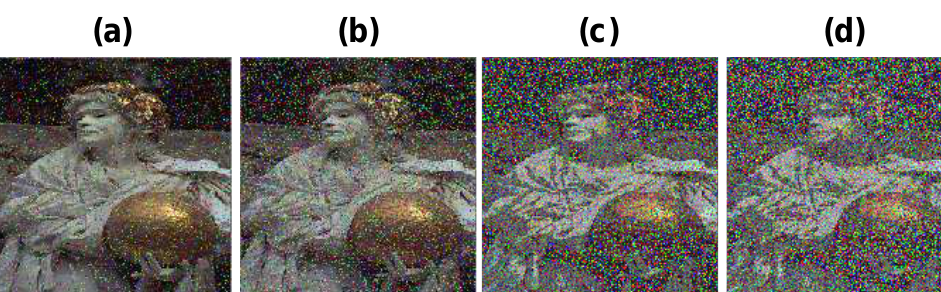
Figure 14. Resistance against salt and pepper on the image in Figure 2d: ( a – d ) images obtained by salt and pepper noise with levels of intensity 0.01, 0.02, 0.10, and 0.20, respectively.